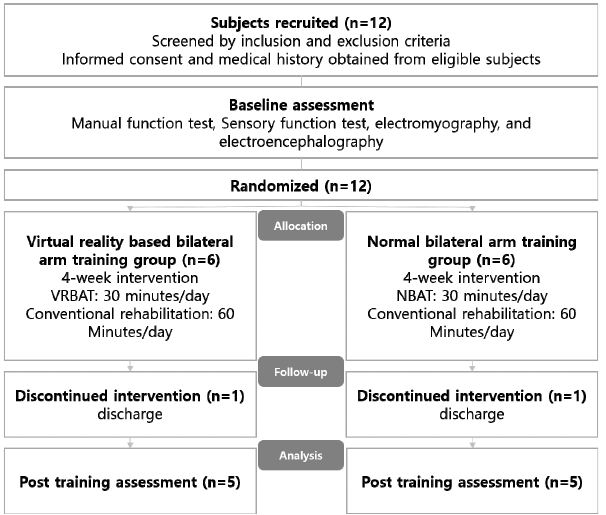
Figure 1. Diagram showing the flow of the study. VRBAT, virtual reality-based bilateral arm training; NBAT, normal bilateral arm training.